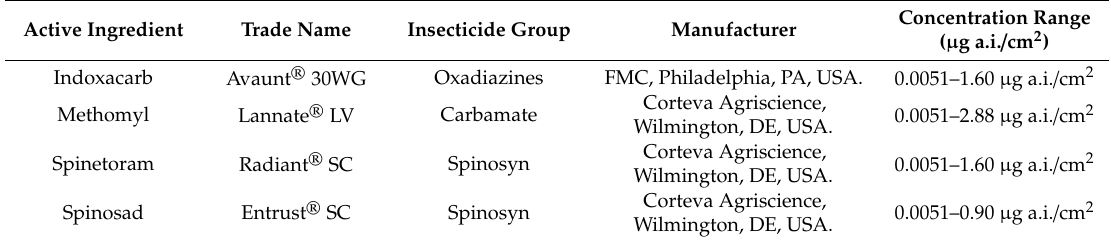
Table 1. Commercial insecticides used to compare the susceptibility of Helicoverpa armigera and Helicoverpa zea in Puerto